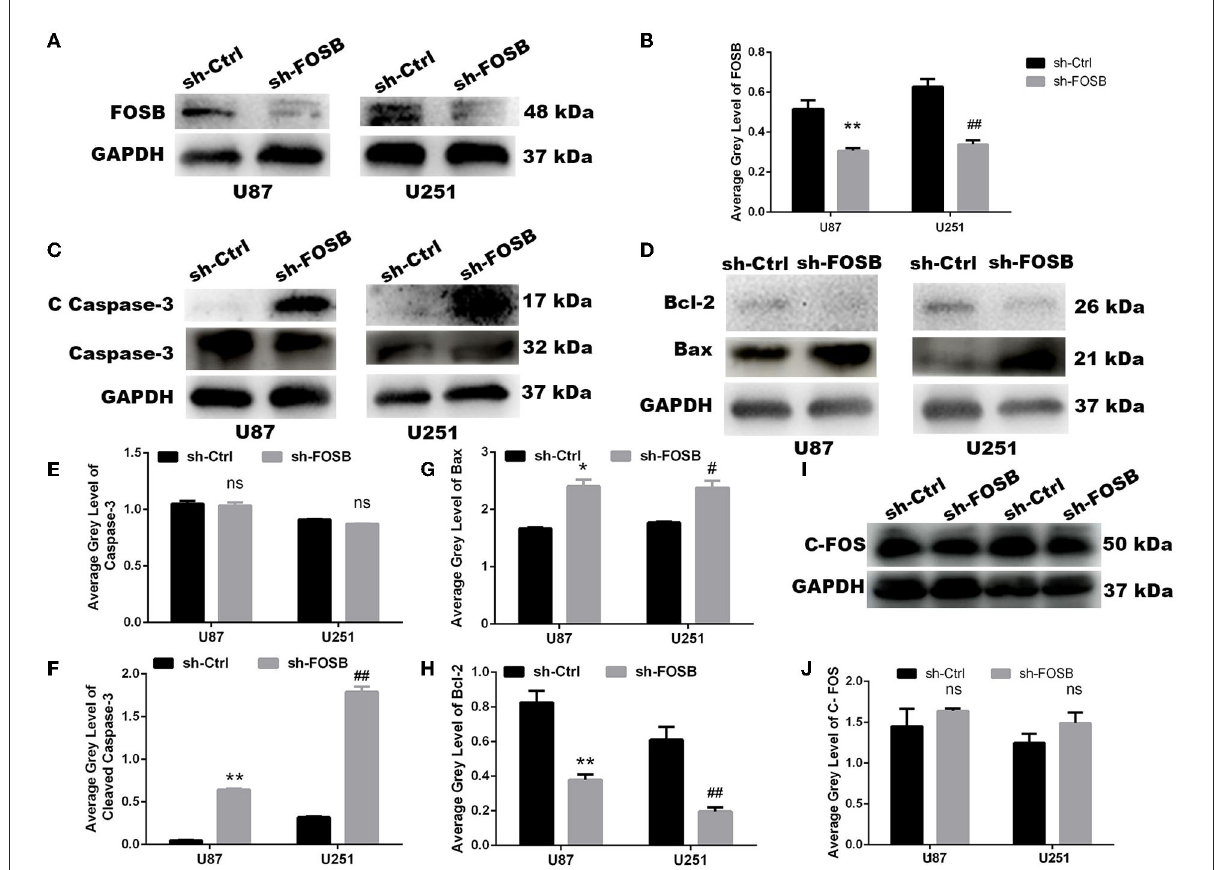
FIGURE2 FOSB regulates apoptosis of GBM cell lines. (A,B) FOSB expression in U87 and U251 cell lines was decreased after knockdown of FOSB ( n = 3, ** P < 0.01 vs. sh-Ctrl of U87 GBM cell lines, ## P < 0.01 vs. sh-Ctrl of U251 cell lines). (C,E,F) Expression of Caspase-3 and Cleaved Caspase-3 after knocking down FOSB in U87 and U251 cell lines. (E) There was no significant difference in the expression of Caspase-3 between sh-FOSB and sh-Ctrl. (F) And the expression of Cleaved Caspase-3 was increased ( n = 3, ** P < 0.01 vs. sh-Ctrl of U87 cell lines, ## P < 0.01 vs. sh-Ctrl of U251 cell lines). (D,G,H) Expression of Bax and Bcl-2 after knocking down FOSB in U87 and U251 cell lines. (G) The expression of Bax was increased ( n = 3, * P < 0.01 vs. sh-Ctrl of U87 cell lines, # P < 0.01 vs. sh-Ctrl of U251 cell lines). (H) At the same time, the expression of Bcl-2 in the sh- FOSB group was significantly lower than that in the sh-Ctrl group. ( n = 3, ** P < 0.01 vs. sh-Ctrl of U87 cell lines, ## P < 0.01 vs. sh-Ctrl of U251 cell lines). (I,J) Expression of C-FOS after knocking down FOSB in U87 and U251 cell lines. (J) There was no significant difference in the expression of C-FOS between sh-FOSB and